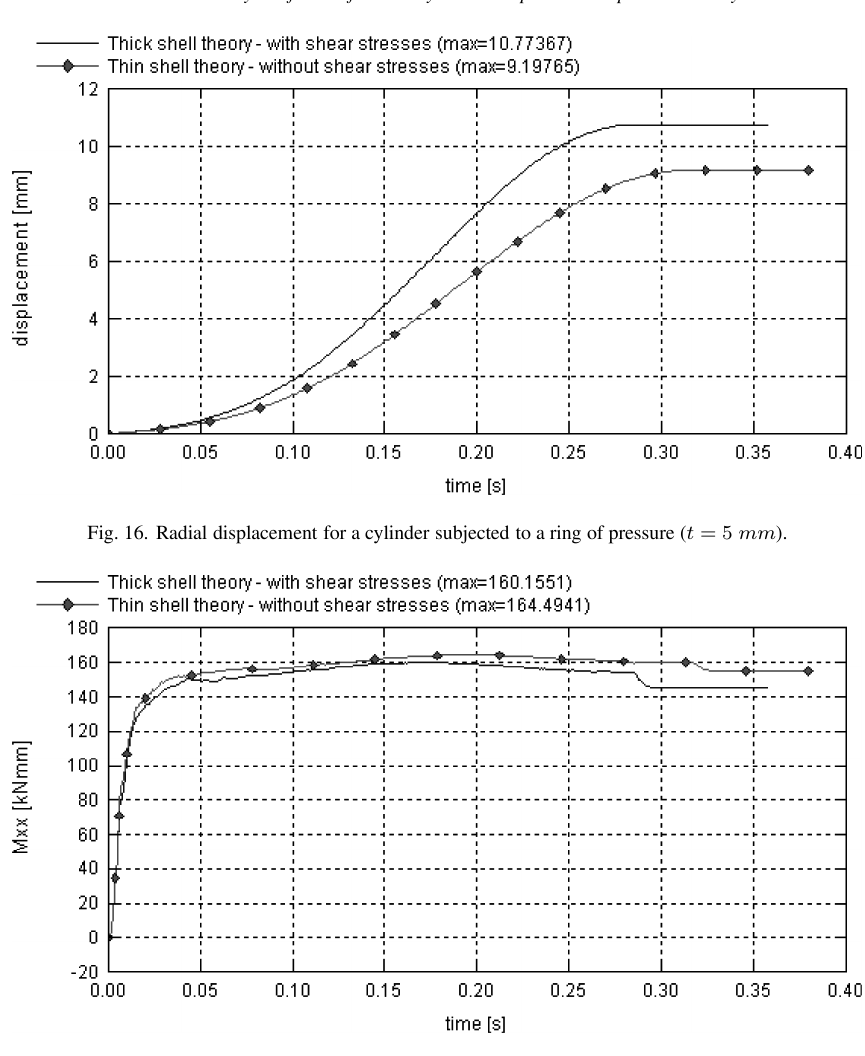
Fig. 17. Bending moment at midspan of the cylinder subjected to a ring of pressure ( t = 5 mm